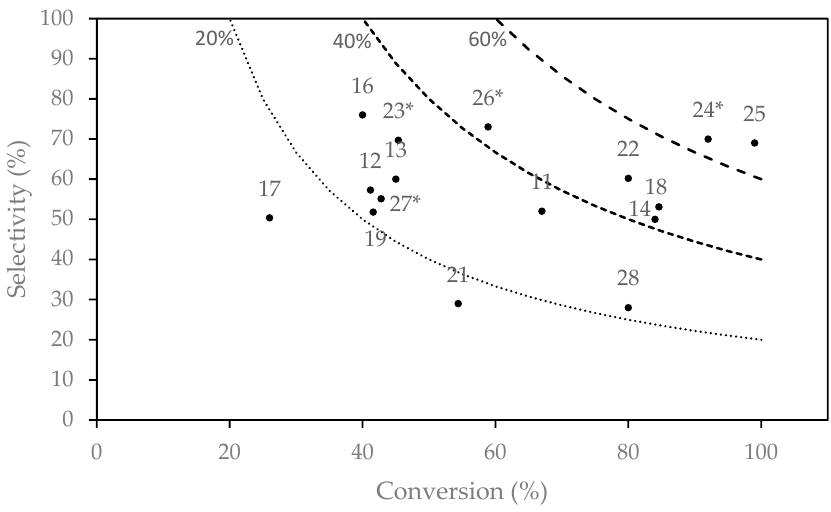
Figure 16. 1,3-Butadiene selectivity versus ethanol conversion for the reviewed catalysts in reference to the ID number in Table 1. * indicates a result obtained from a two-step process.